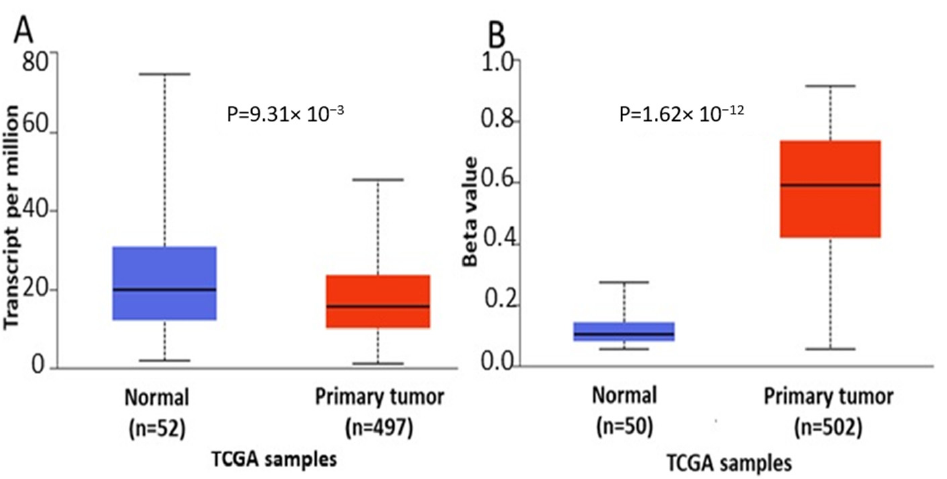
Figure 5. Analysis of ENPP2 between primary PC tumors and normal tissues using the UALCAN database, concerning ( A ) mRNA expression and ( B ) DNA methylation. Abbreviations: TCGA: The Cancer Genome Atlas, PC: Prostate